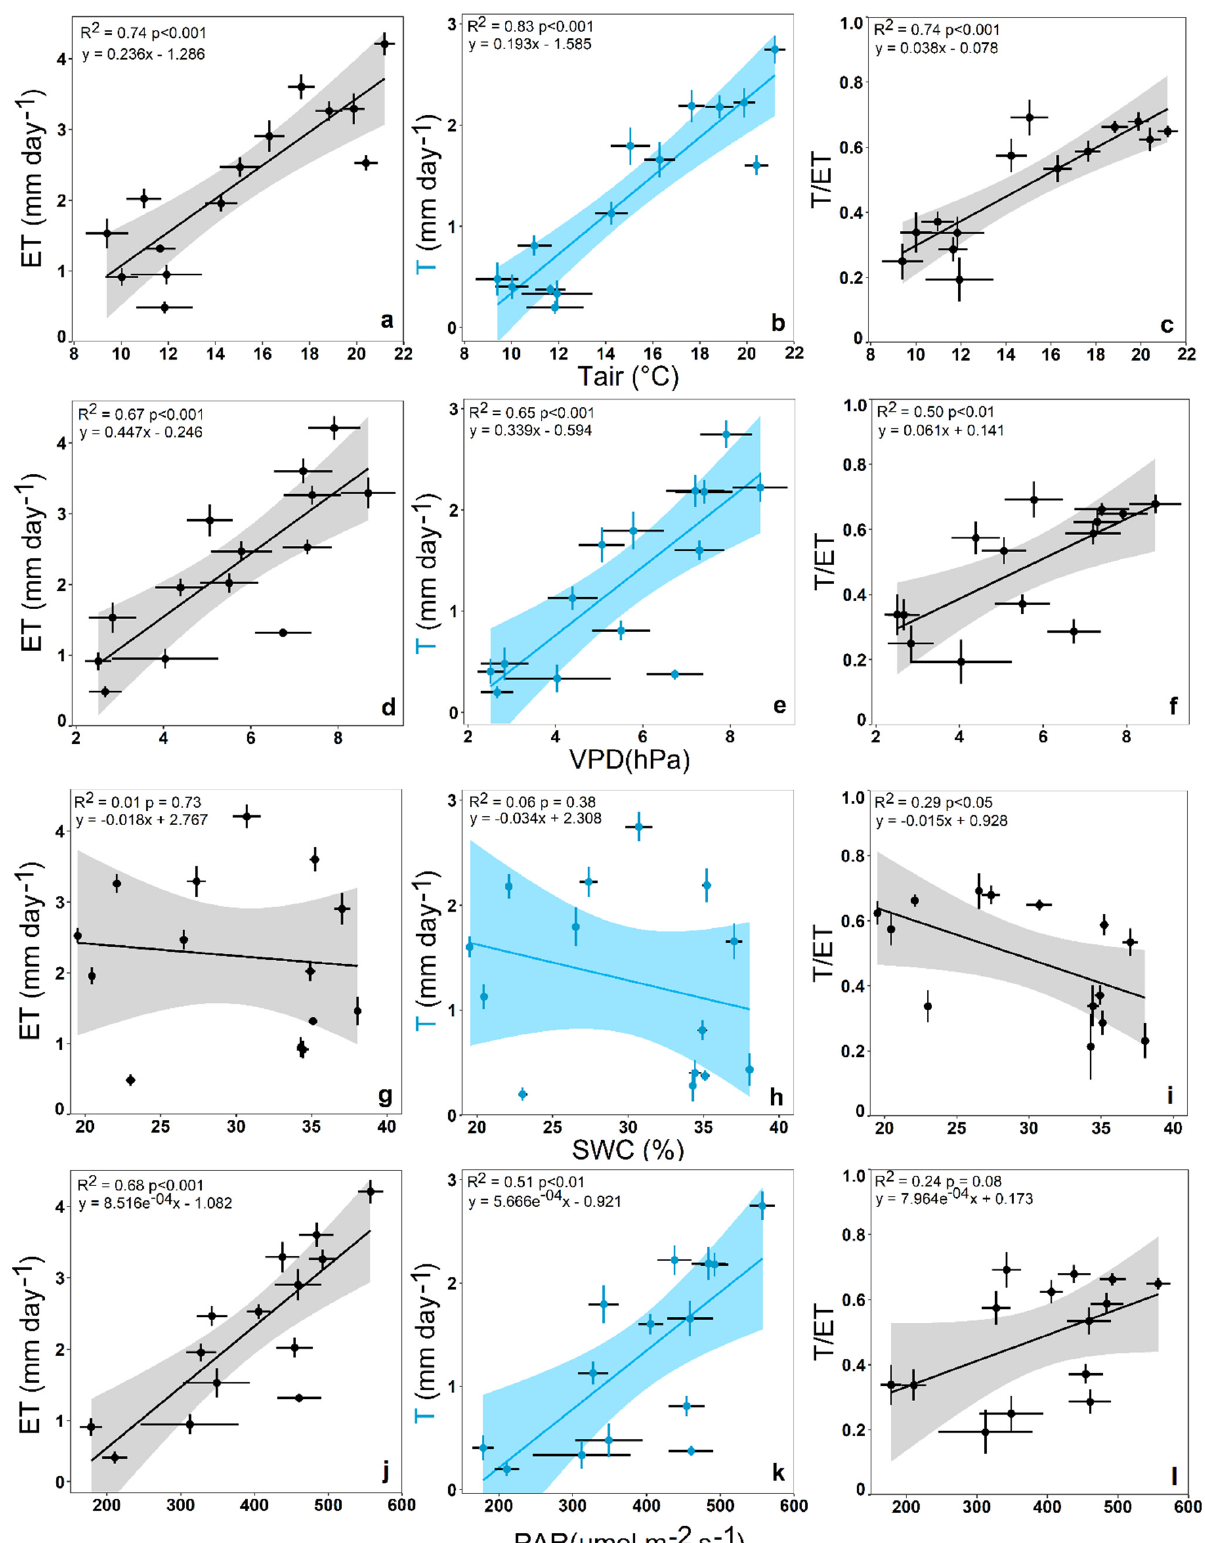
Figure 6. Impact of monthly mean air temperature ( a , b , c ), vapour pressure deficit ( d , e , f ), soil water content ( g , h , i ) and photosynthetic active radiation ( j , k , l ) on monthly mean ecosystem transpiration, evapotranspiration, and transpiration/evapotranspiration ratio during the 2019–2020 (April–October) period.